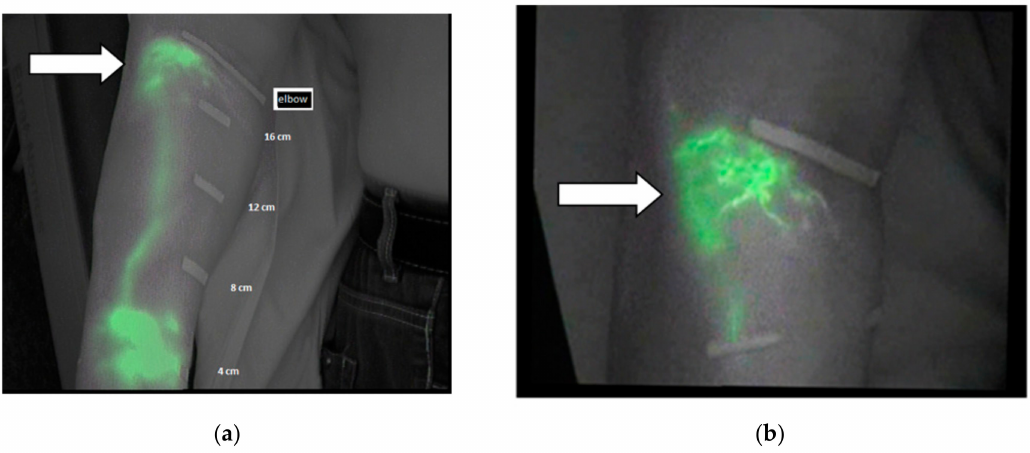
Figure 3. ( a ) Di ff use pattern under the elbow before the treatment and ( b ) splash pattern after the treatment as indicated by white